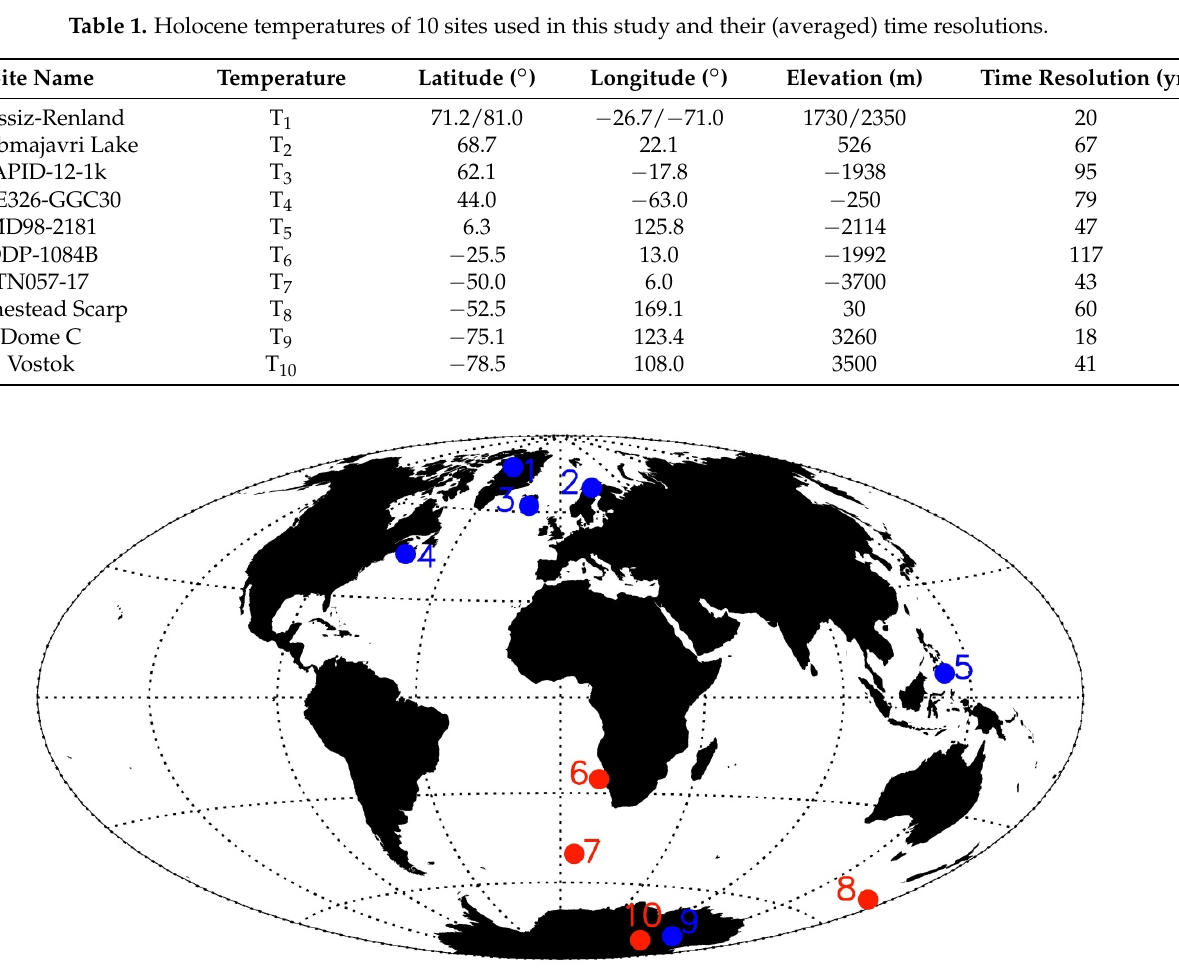
Figure 1. Locations of 10 sites of the reconstructed temperature data adopted in this study. Blue dots denote locations of temperatures with positive correlations to sunspot number (SSN) reported in Table 1 (see also Figure 5), and red dots denote those with negative correlations to SSN. A rough pattern of opposing inter-hemispheric seesaw temperature responses to solar variations on the millennial timescale over the Holocene, with the one exception of T 9 , is